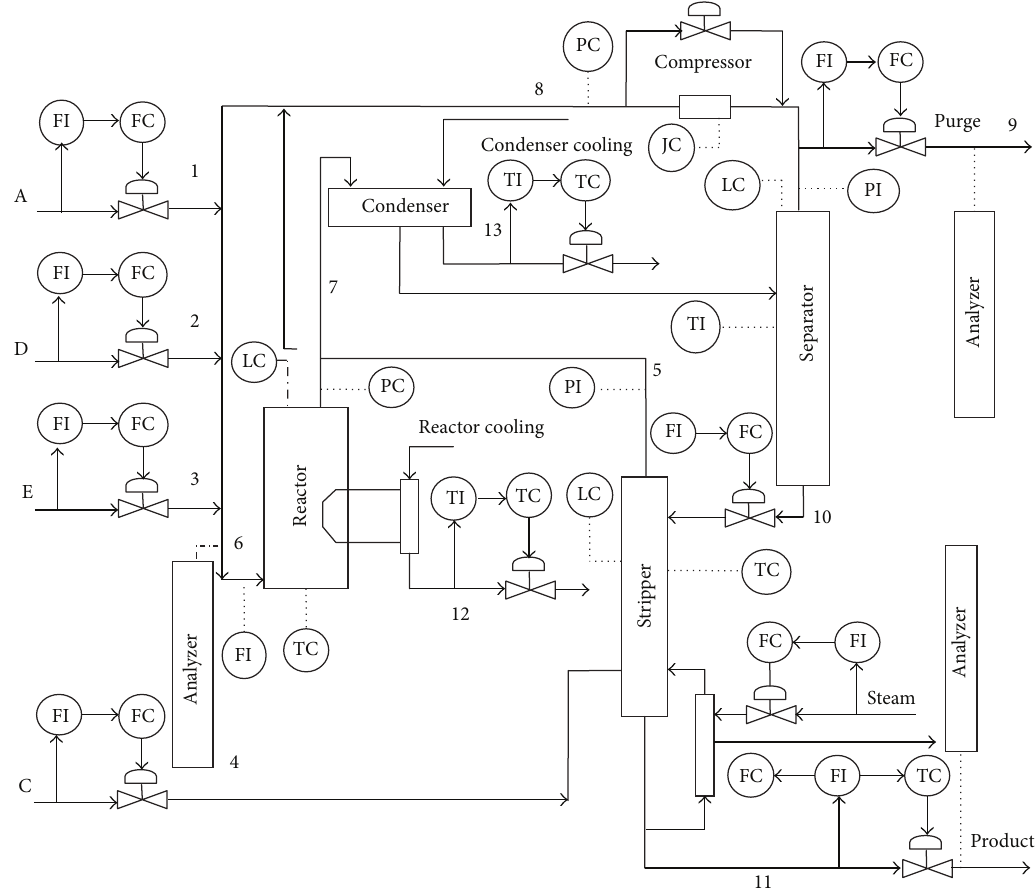
Figure 4: The technological process of Tennessee